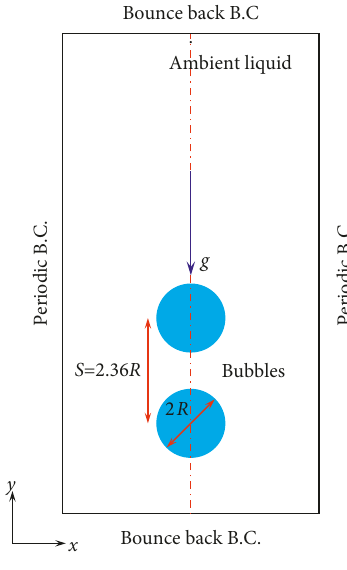
Figure 1: Numerical results of a single bubble rising in ambient liquid for different nondimensional parameters at D � 0 . 5, ρ μ l / μ b � 100. (a) Interface topologies at t ∗ � 3; (b) rising velocities for t ∗ ≤